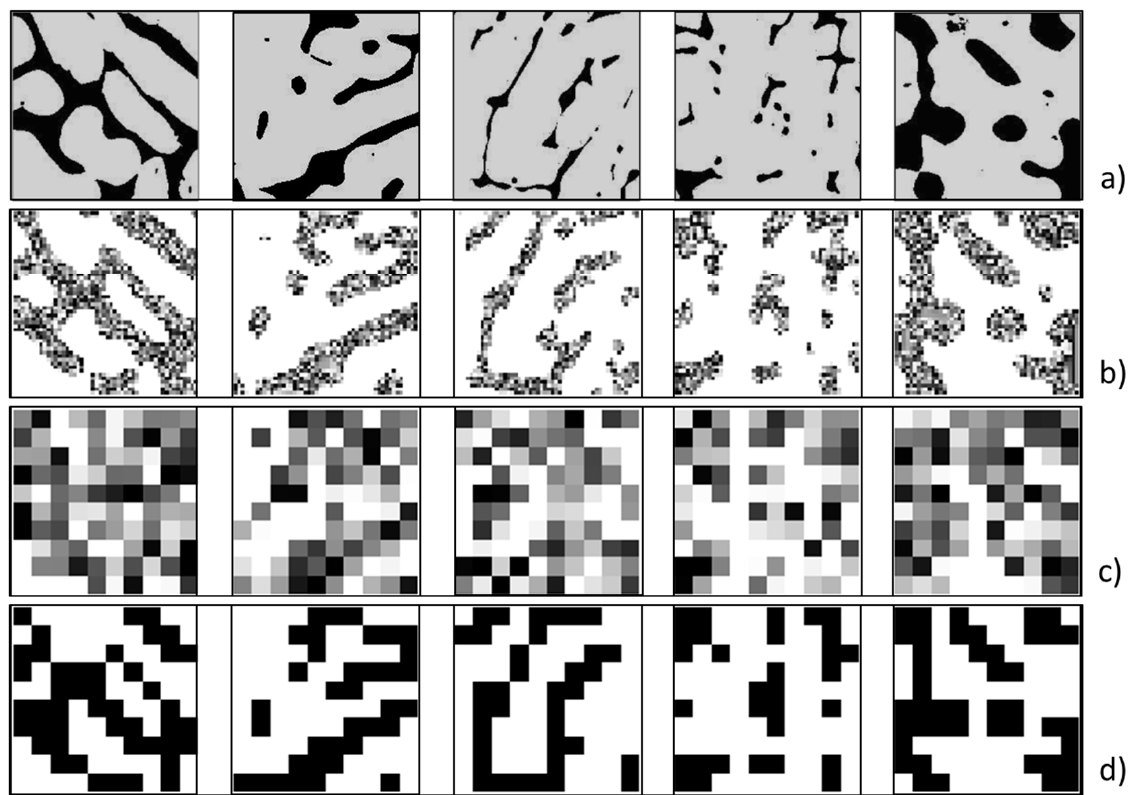
Figure 5. Feature maps of five samples extracted from different convolutional layers. ( a ) Original images with 200 × 200 pixels; ( b ) feature maps with 50 × 50 × 32 pixels through three Conv2D blocks; ( c ) feature maps with 10 × 10 × 1 pixels through APP; and ( d ) feature maps in black and white.